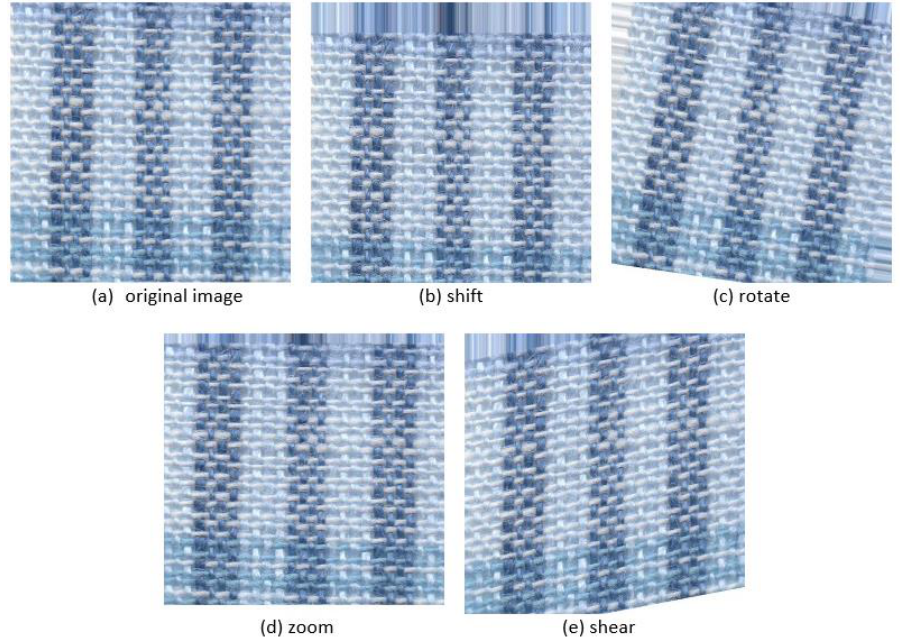
Figure 5. Various augmentation techniques applied to an original image .